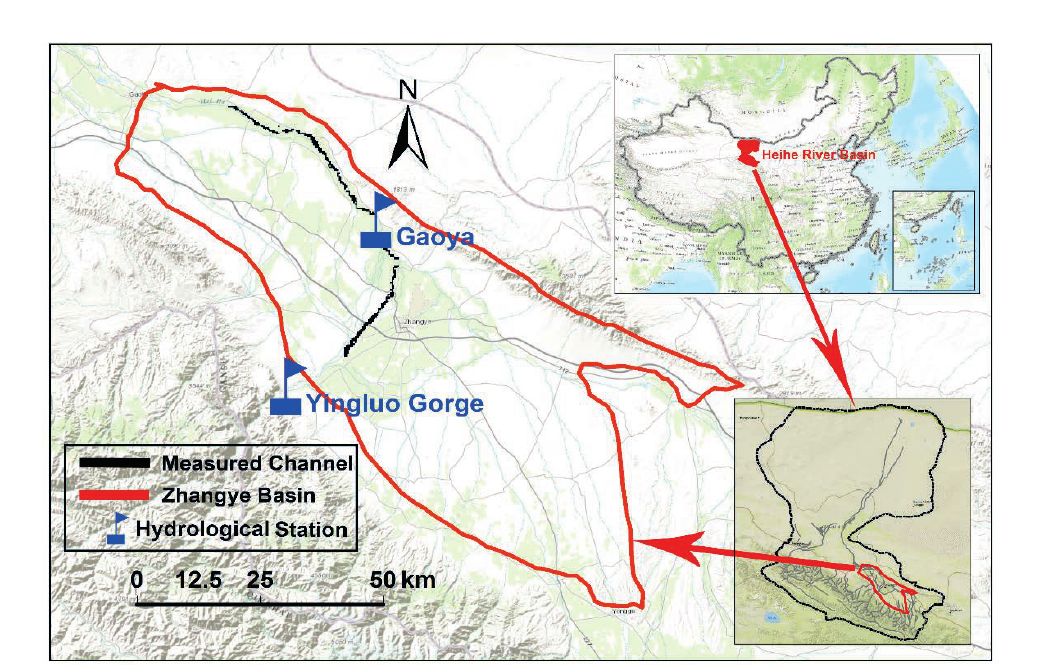
Fig. 1 Location of the Zhangye basin and the stream channels surveyed by airborne remote